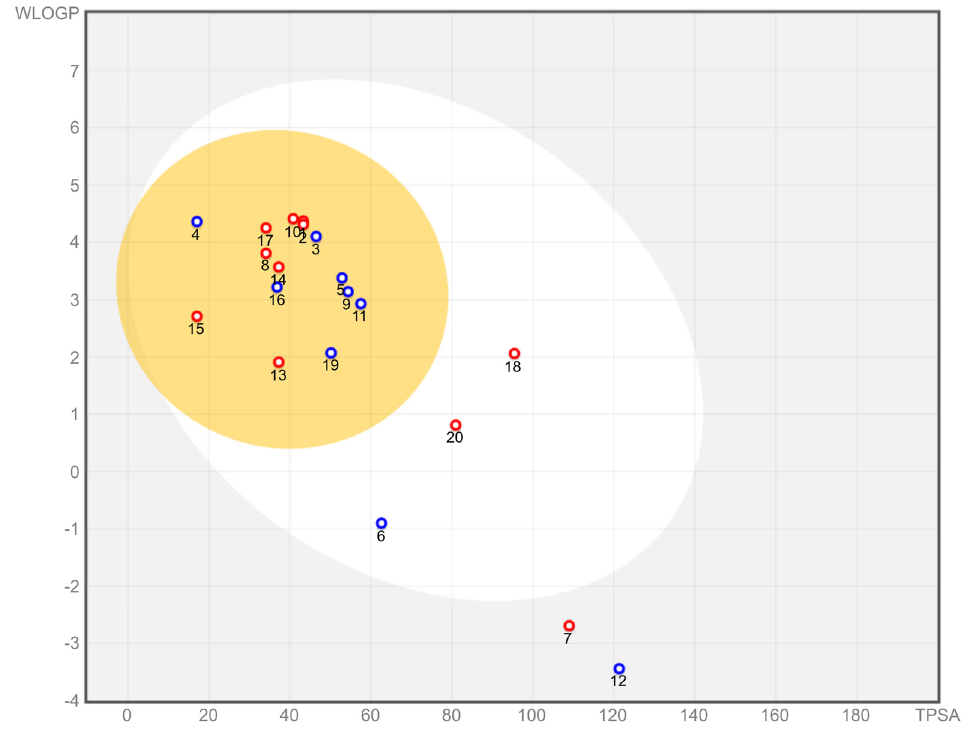
Figure 2. SwissADME BOILED-Egg diagram for brain access and gastrointestinal absorption. The meaning of colors is the following: white region = high intestinal absorption, yellow region = BBB-permeant, red color = not a p-glycoprotein substrate.